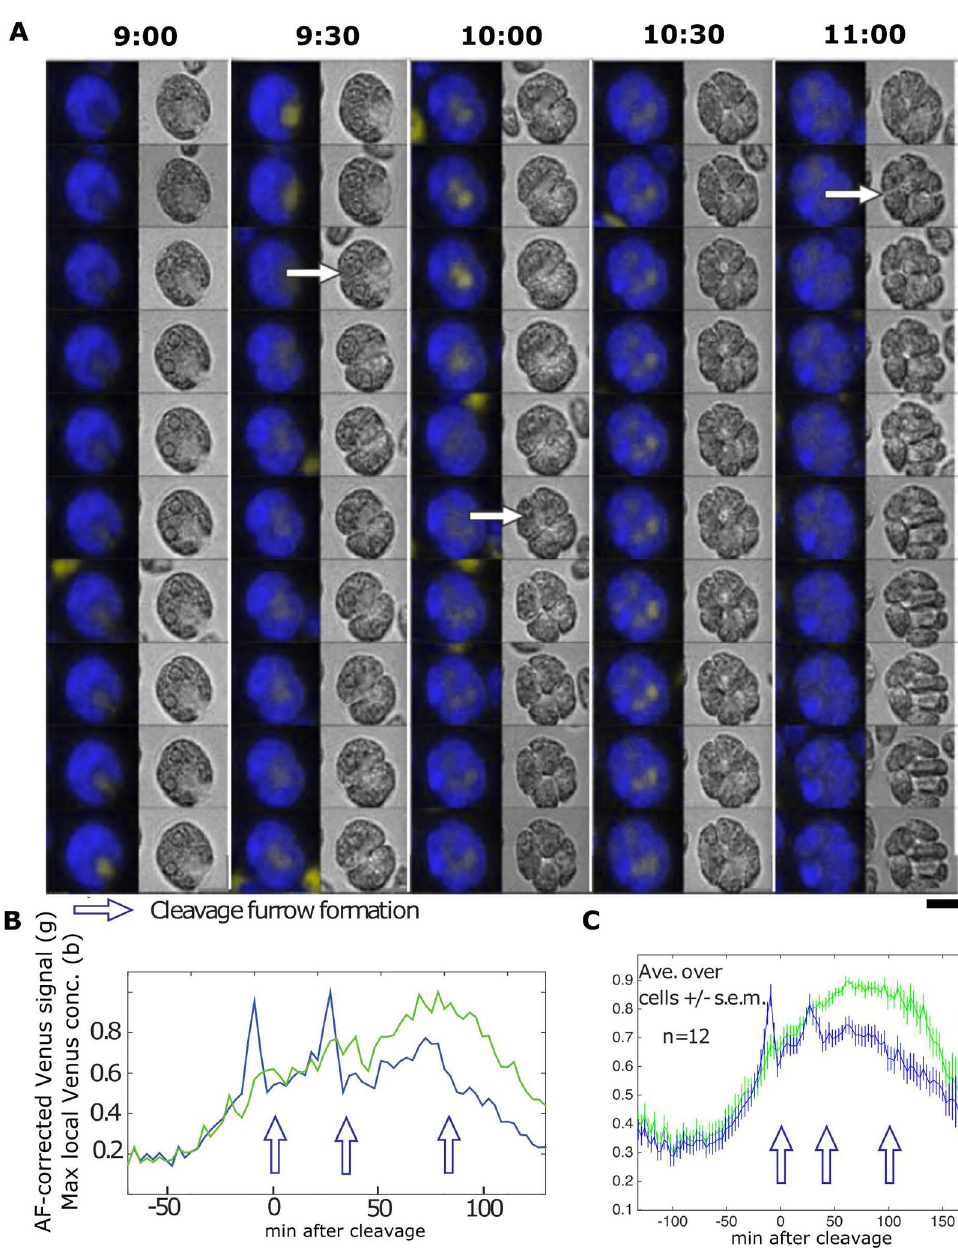
Fig 5. Live cell time-lapse of CDKB1 : Venus-TG cells. (A) Brightfield image (right), and a composite of chloroplast autofluorescence in blue and CDKB1-Venus signal in yellow (left). Time indicated on top of each strip is hours and minutes after beginning of time-lapse. The indicated time corresponds to the top cell in each strip. Each subsequent cell going down is from an image captured every 3 minutes. Arrows: cleavage furrow formation. Scale bar: 5 microns. (B) Quantification of YFP signal in the cell shown in (A). Green line: total YFP signal; blue line: estimated concentration (YFP signal per area) in the minimal convex hull calculated to contain 50% of total signal. (C) The same plots for the average and s.e.m. of 12 cells. All traces adjusted to a maximum signal of 1 before averaging. In B and C, note reproducible peak of concentration of CDKB1-Venus 1–2 frames before cleavage furrow formation. This pattern repeated in successive cycles; the peak was reduced in intensity in the averaged data, most likely due to slight asynchrony in timing comparing different cells.